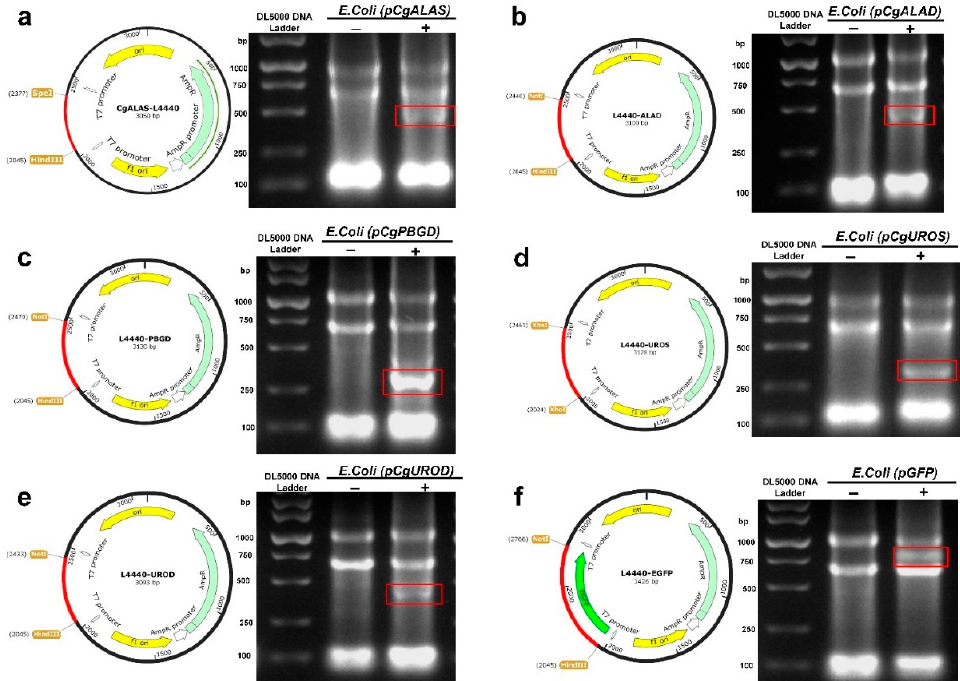
Figure 1. Plasmid constructs and induction assays. The red box indicates bands associated with ALAS, ALAD, PBGD, UROS, UROD and EGFP double-stranded RNAs, from the RNA extraction of the IPTG-induced E. coli transformed with CgALAS -L4440, CgALAD -L4440, CgPBGD -L4440, CgUROS -L4440, CgUROD -L4440, EGFP-L4440: ( a ) Plasmid construction of CgALAS -L4440 with CgALAS fragment sizes and total plasmid sizes; ( b ) Plasmid construction of CgALAD -L4440 with CgALAD fragment sizes and total plasmid sizes; ( c ) Plasmid construction of CgPBGD -L4440 with CgPBGD fragment sizes and total plasmid sizes; ( d ) Plasmid construction of CgUROS -L4440 with CgUROS fragment sizes and total plasmid sizes; ( e ) Plasmid construction of CgUROD -L4440 with CgUROD fragment sizes and total plasmid sizes; ( f ) Plasmid construction of EGFP-L4440 with EGFP fragment sizes and total plasmid sizes.